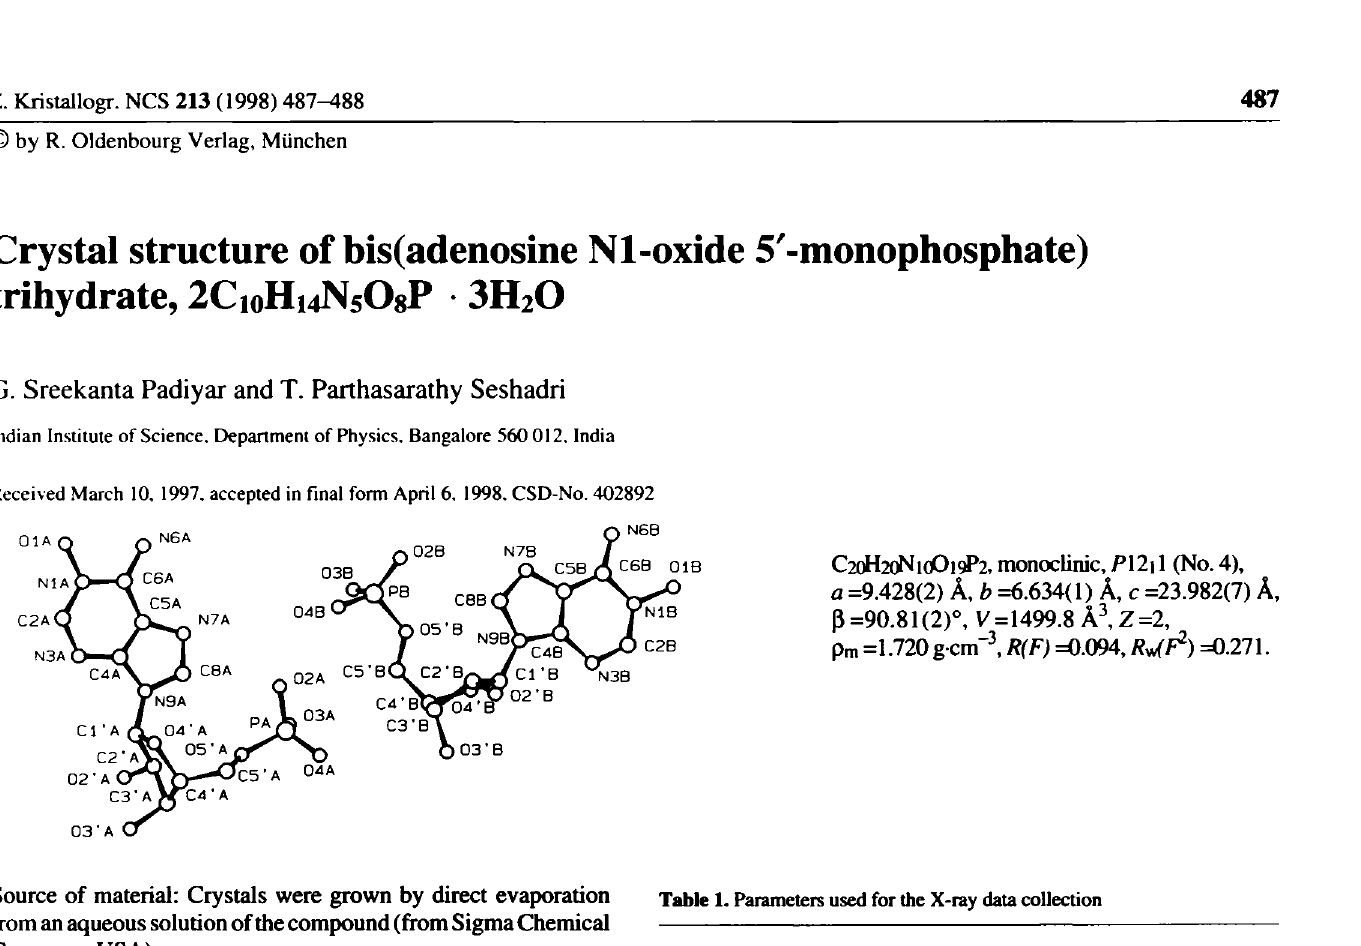
Table 1. Parameters used for the X-ray data collection